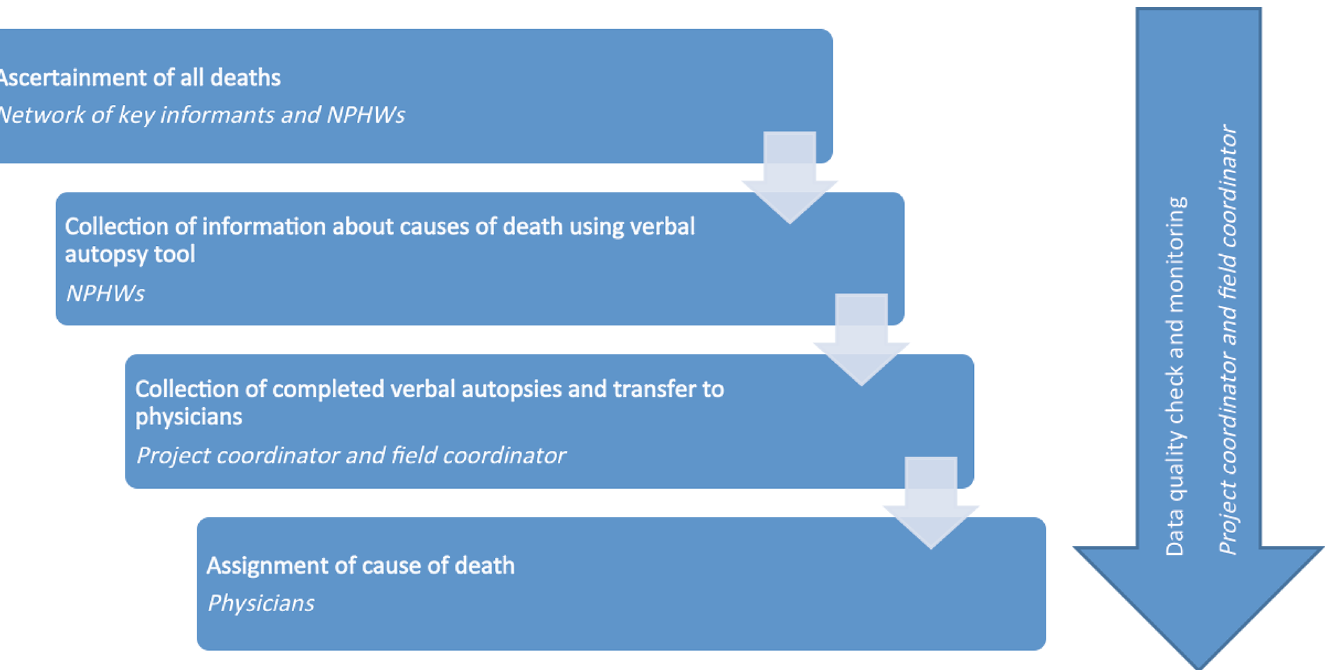
Fig 1. Overall design of the verbal autopsy based mortality surveillance